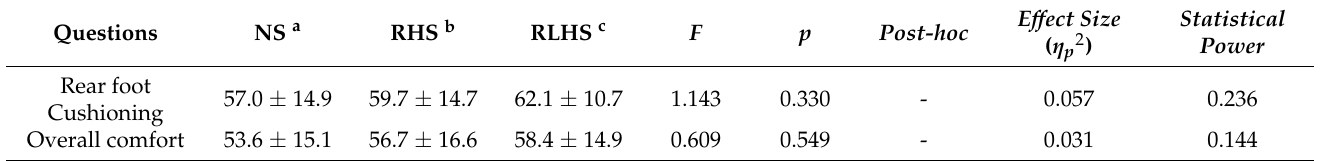
Table A3. Descriptive information of comfort test.